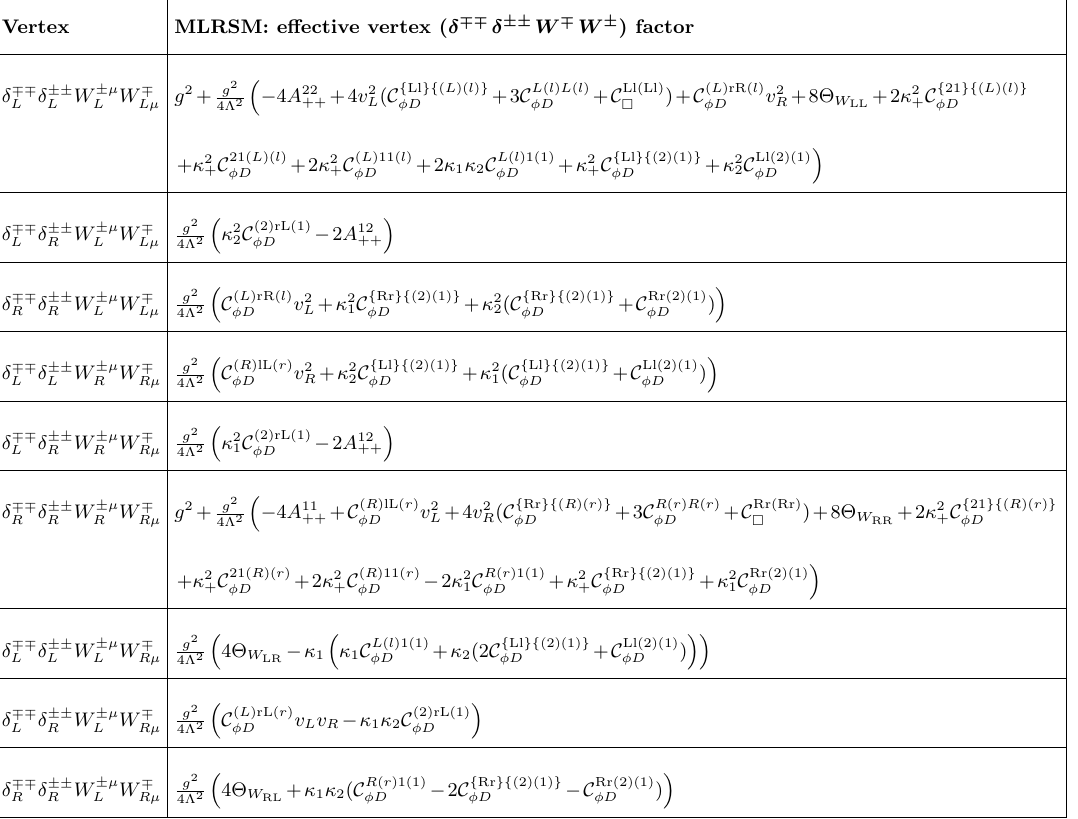
Table 44. MLRSM: coupling of a pair of doubly charged scalars ( (cid:14) (cid:6)(cid:6) ) with a pair of two charged gauge bosons ( W (cid:6) ) in unphysical basis. These can be easily translated in physical gauge boson L;R basis using rotation matrix e . R a